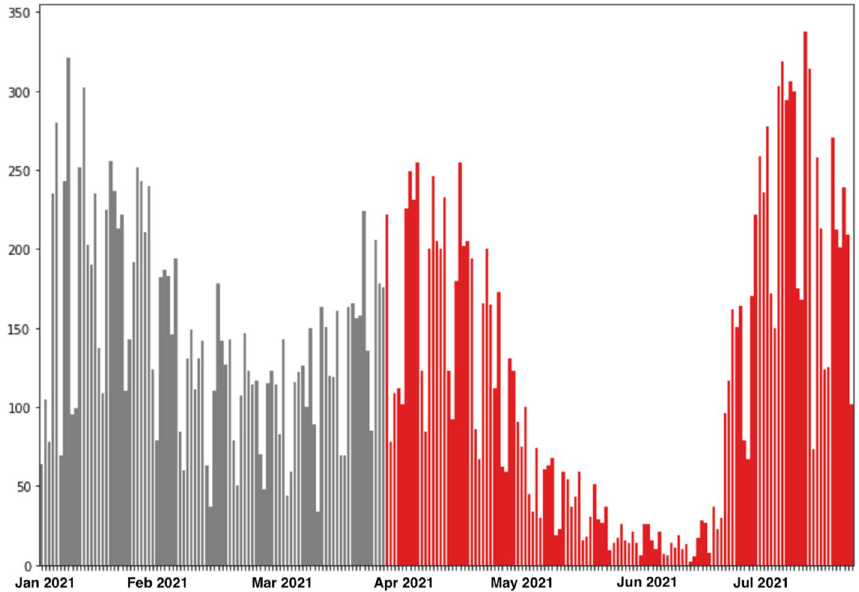
Figure 1. Epidemiologic curve from 01-001-2021 until 31-07-2021. Grey shows the predominance of the Alpha variant and red the predominance of the Delta